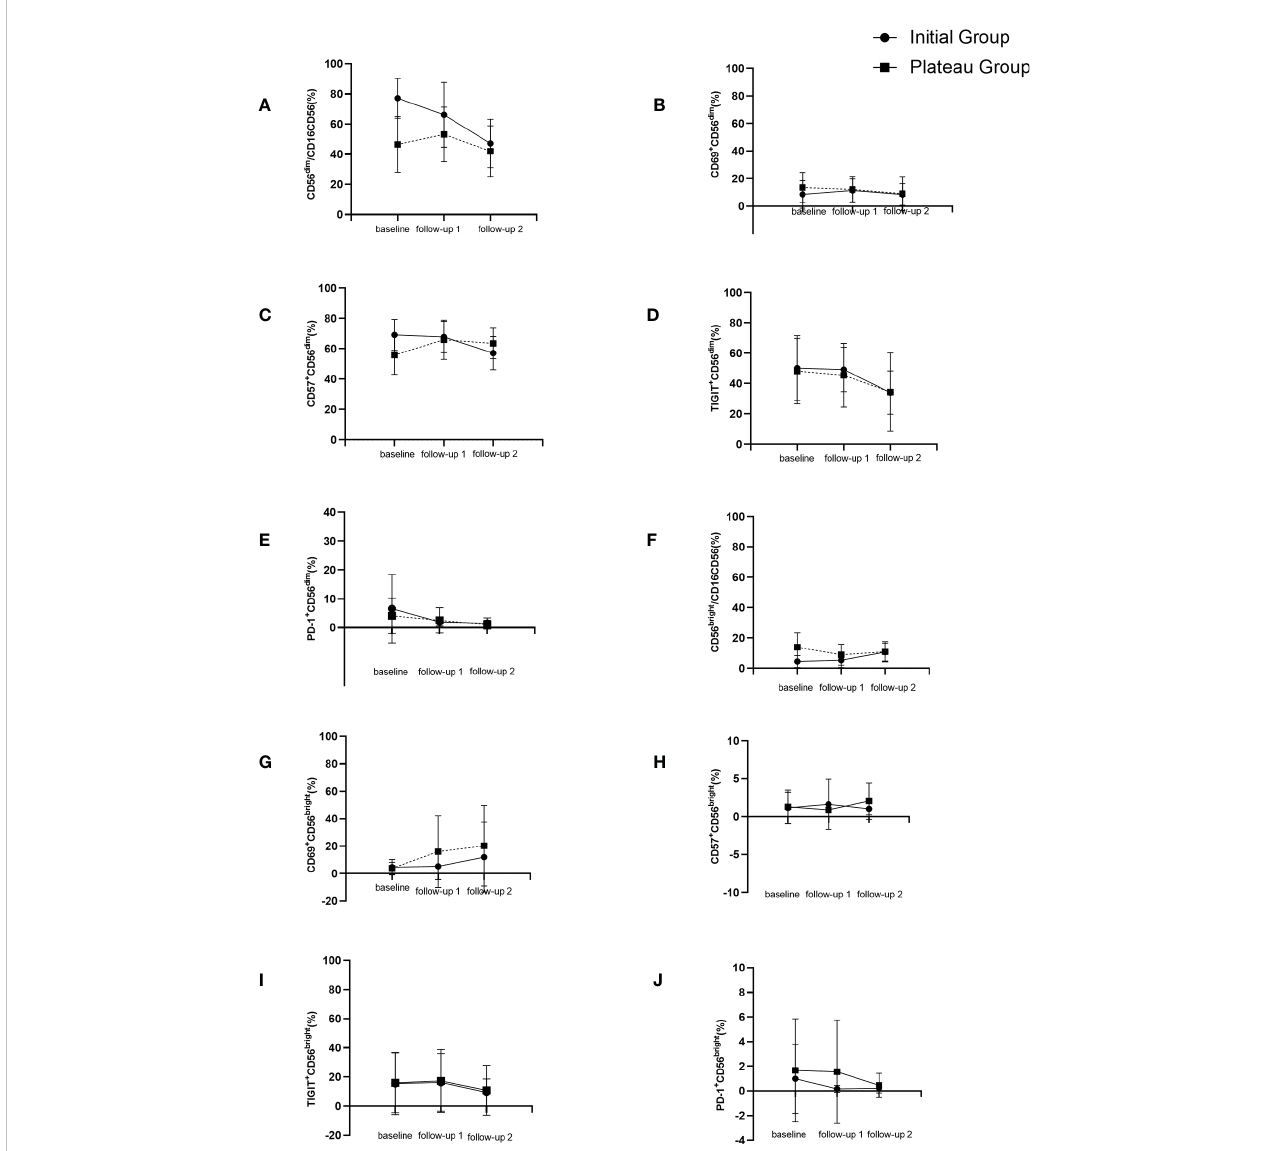
FIGURE 3 Dynamic changes of NK cell subgroups with follow-up time. (A) changes of CD56 dim CD16 + (%) during follow up. (B) changes of CD69 + CD56 dim (%) during follow up. (C) changes of CD57 + CD56 dim (%) during follow up. (D) changes of TIGIT + CD56 dim (%) during follow up. (E) changes of PD-1 + CD56 dim (%) during follow up. (F) changes of CD56 bright CD16- (%) during follow up. (G) changes of CD69 + CD56 bright (%) during follow up. (H) changes of CD57 + CD56 bright (%) during follow up. (I) changes of TIGIT + CD56 bright (%) during follow up. (J) changes of PD-1 + CD56 bright (%) during follow